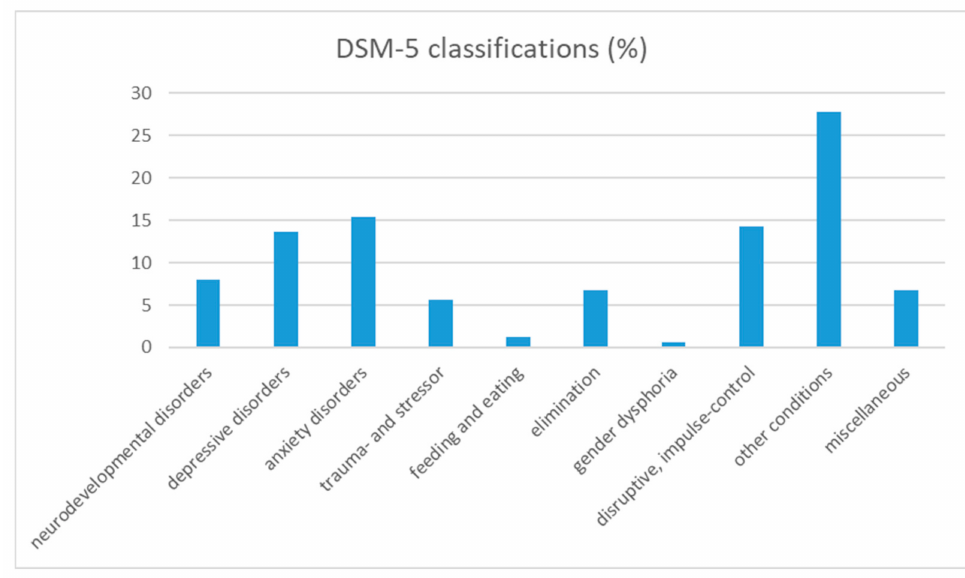
Figure 1. Distribution (%) of DSM-5 Classifications in the Clinical